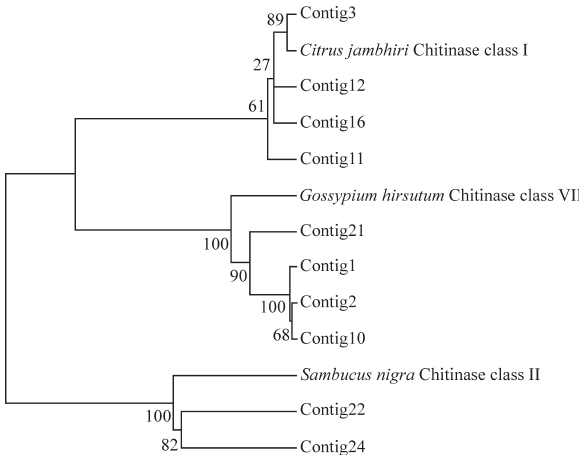
Figure 6 - A neighbor-joining tree of PR-3 homologues from Citrus con- structed and visualized in MEGA program from deduced amino acids se- quences alignment in Clustalx. The numbers indicate in percentage bootstrap analysis (1,000 replicates) of the data supporting the branches. The following sequences were taken from the EMBL GeneBank: Citrus jambhiri acid class I chitinase (gi|23496445); Sambucus nigra class